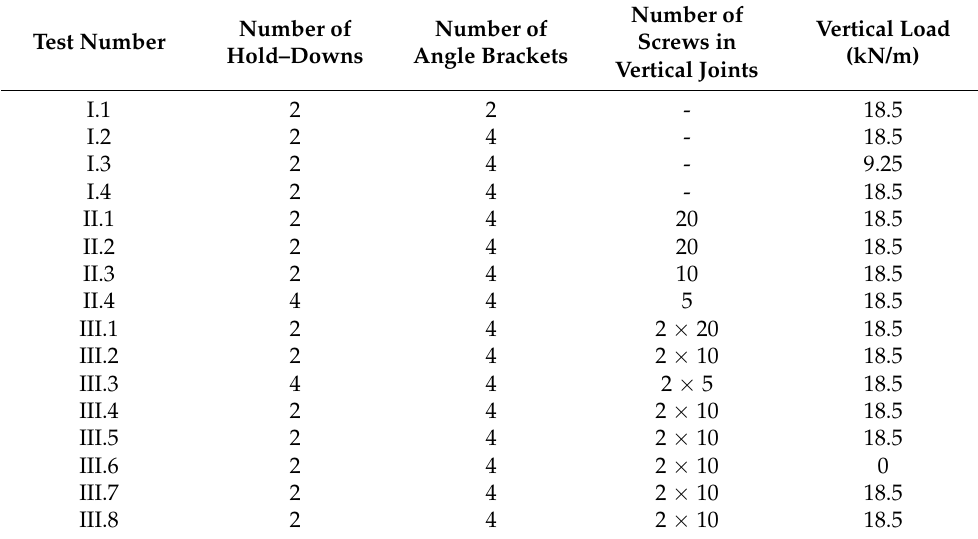
Figure 2. Configuration of the three panels typologies tested by [41], where ( a ), ( b ) and ( c ) identify the I, II and III wall configurations, respectively. Table 1. Wall configurations tested